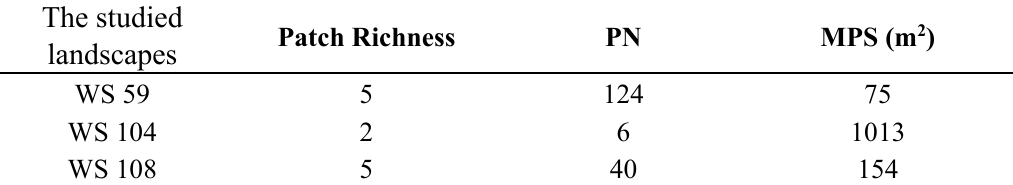
Table 3. Landscape level